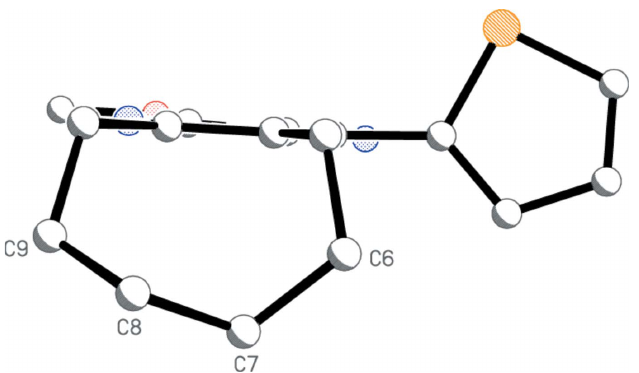
Figure 5 The molecular packing of compound 1a , viewed parallel to the b axis, showing the ‘weak’ hydrogen bonds (drawn as dashed bonds). Atom labels indicate the asymmetric unit.